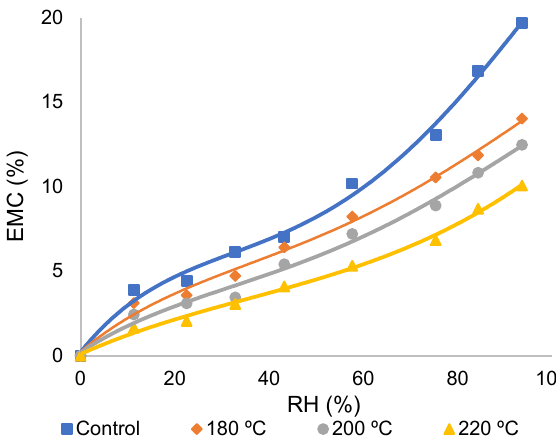
Figure 1. Sorption isotherms of specimens.